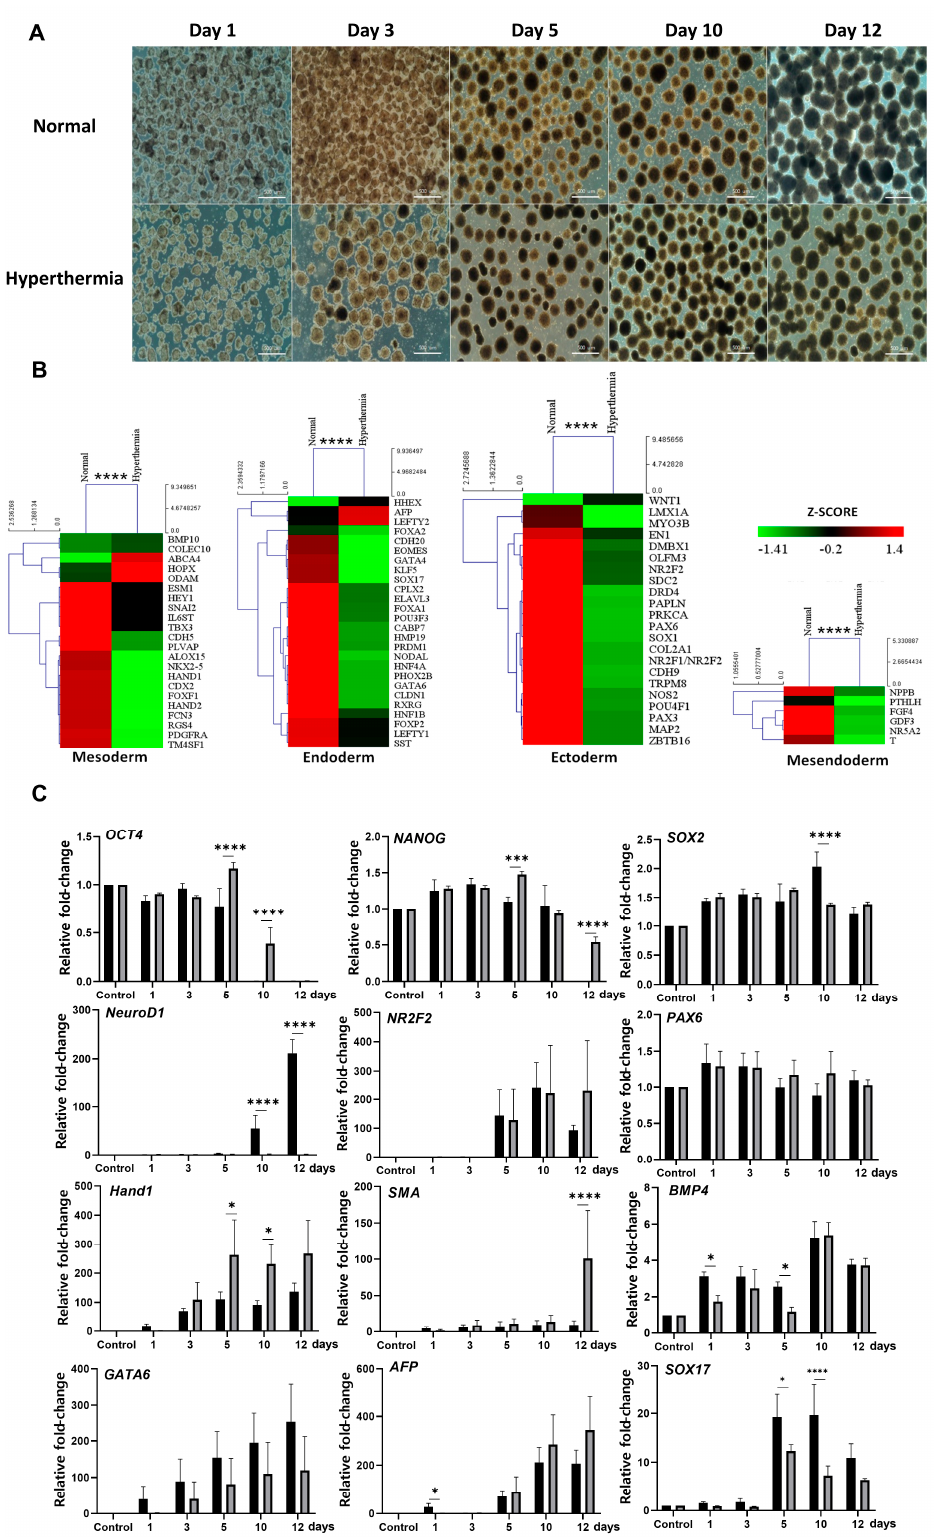
Figure 3. Hyperthermia disturbs spontaneously differentiating human EBs (hEBs) through UPR induction. ( A ) Phase-contrast images showing the in vitro spontaneous differentiation of the hESCs for the indicated days after exposure to hyperthermia or normothermia for 4 h. ( B ) Heatmap of the differentiation potential of all the gene classes (mesoderm, endoderm, ectoderm, mesendoderm, and self-renewal) of EBs at day 12 after exposure to hyperthermia or normothermia for 4 h. ( C ) Expression